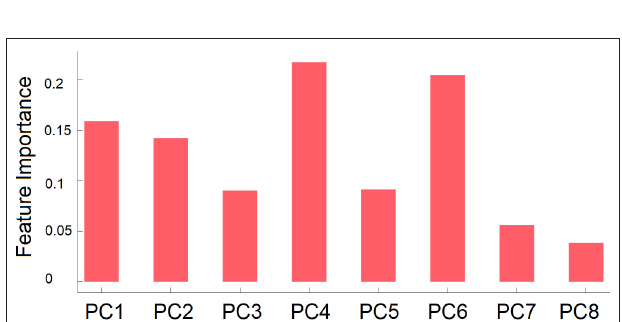
FIGURE 3 | Mean feature importance of the right PCs used as features in group classification by GB classifier. PC n is the PC that explained the n -th largest amount of